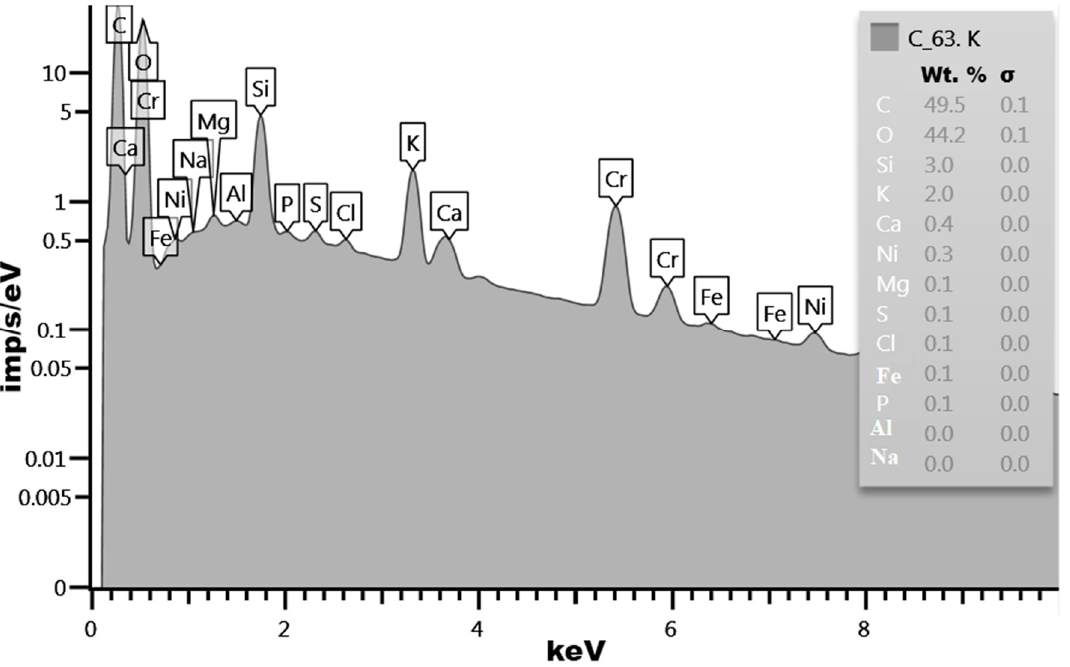
Figure 5 . Spectrum of energy dispersive microanalysis of wheat straw powder .